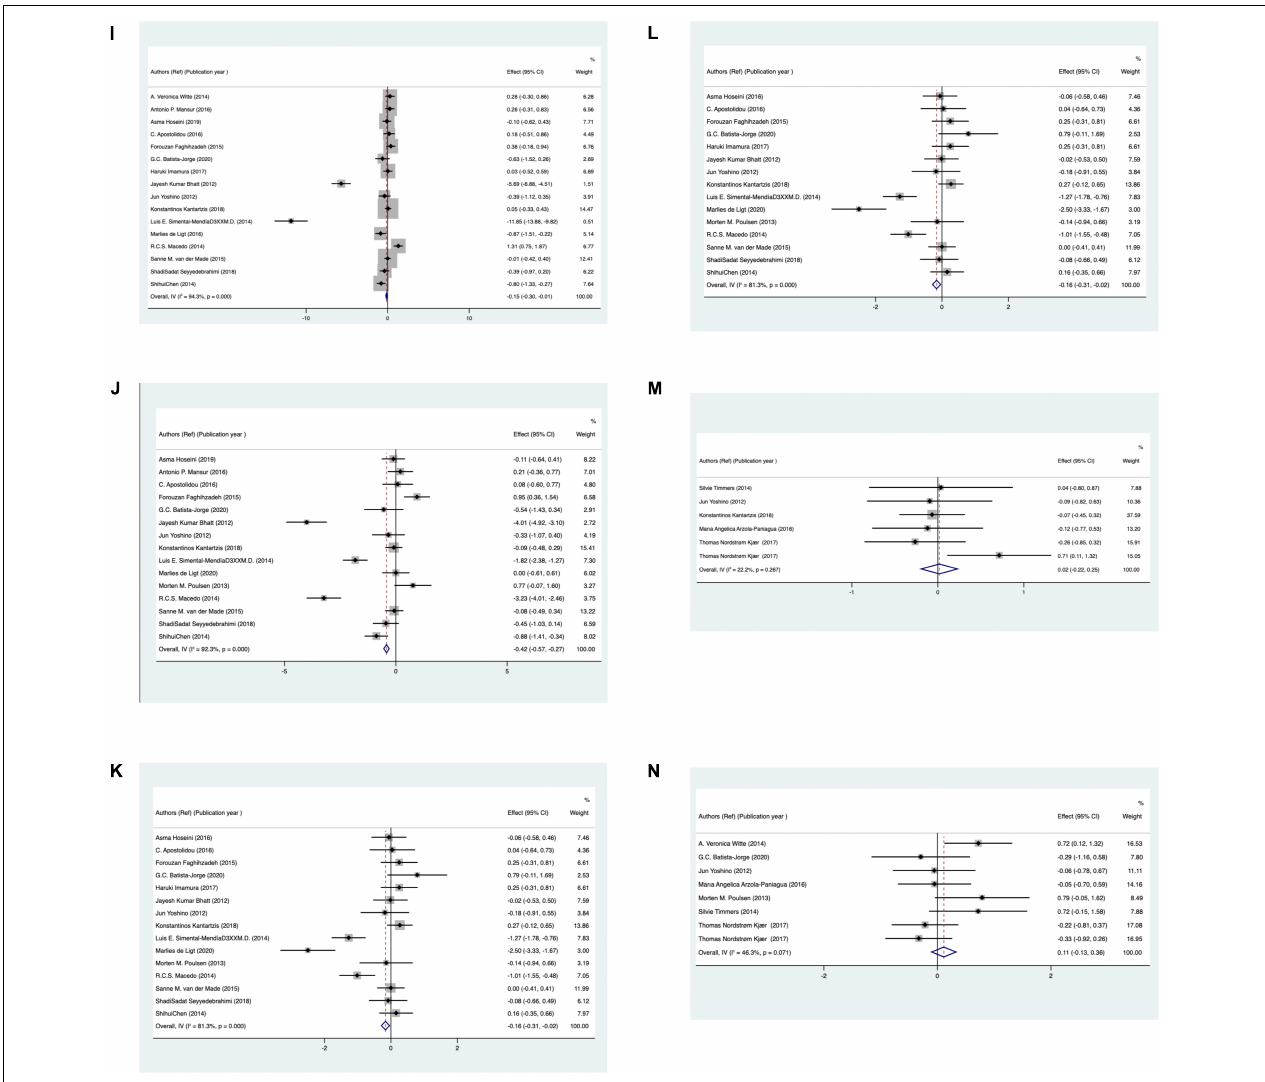
FIGURE 3 | Standardized mean difference of metabolic markers meta-analysis for (A) body weight, (B) for body mass index, (C) for waist circumference, (D) fasting glucose, (E) insulin, (F) HOMA index, (G) HbA1c, (H) fat percentage, (I) total cholesterol, (J) low density lipoprotein cholesterol, (K) high density lipoprotein cholesterol, (L) triglyceride, (M) for adiponectin, (N) for leptin levels in resveratrol and control